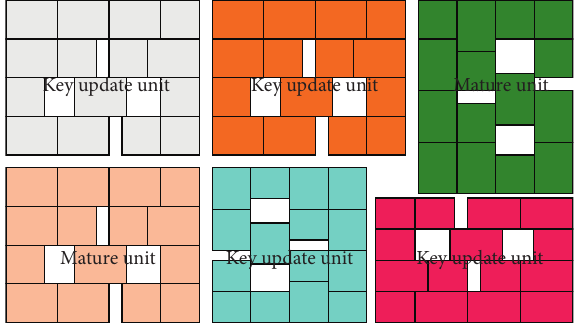
Figure 8: Urban landscape renewal